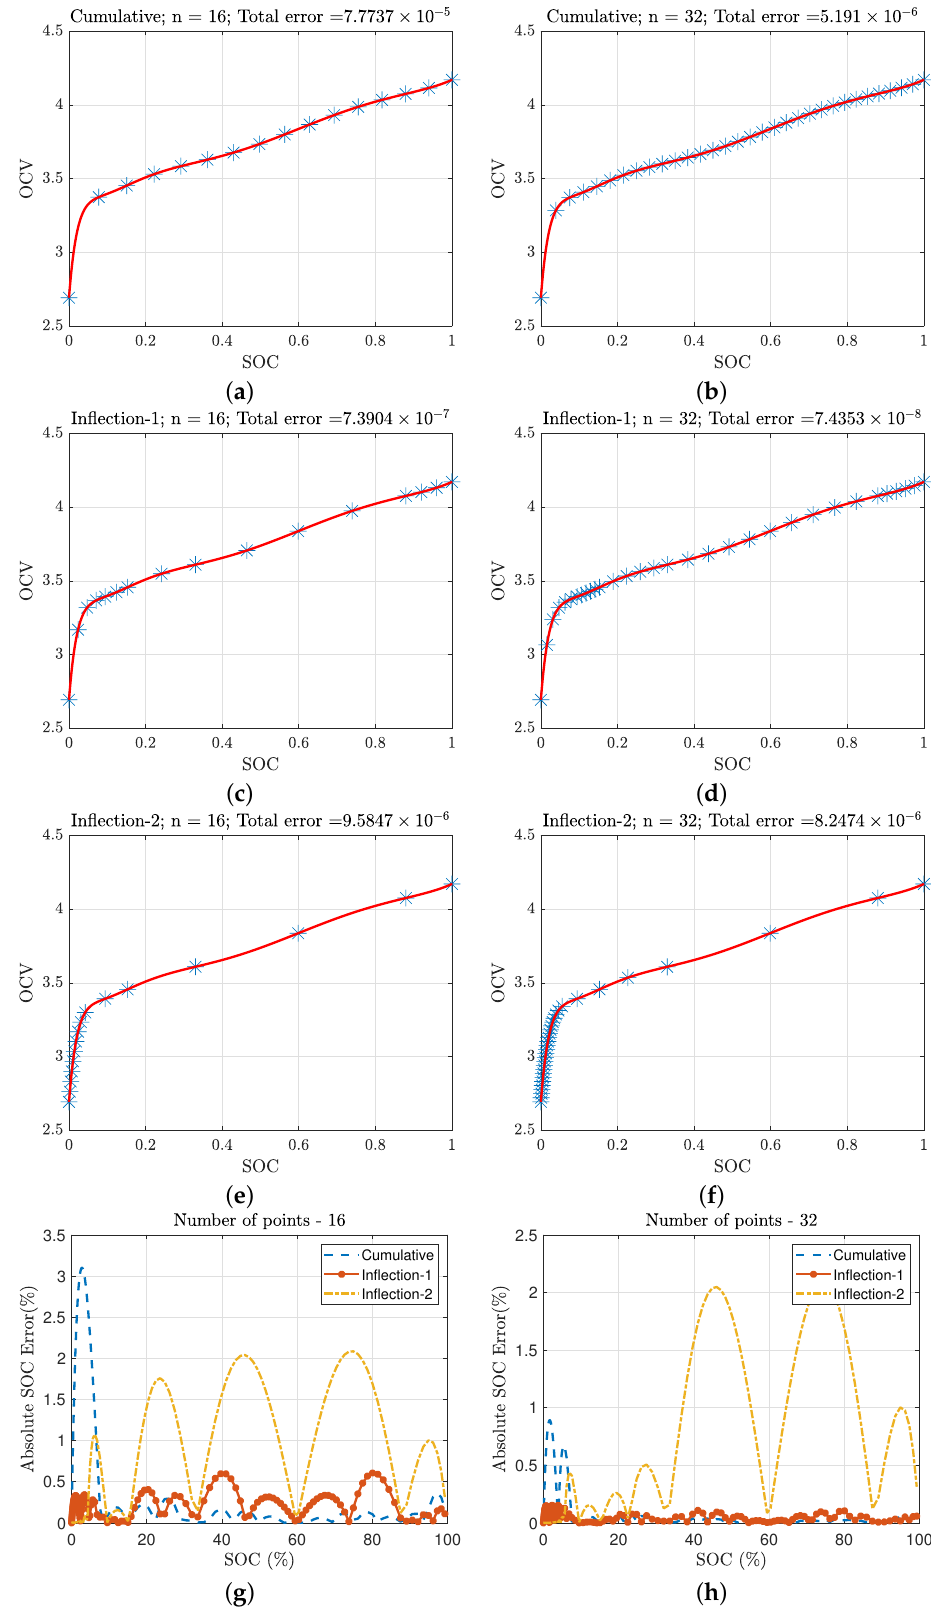
Figure 14. Tabular approximation error—( a ) cumulative-16 point, ( b ) cumulative-32 point, ( c ) inflection-1-16 point, ( d ) inflection-1-32 point, ( e ) inflection-2-16 point, ( f ) inflection-2-32 point, ( g ) SOC lookup error for 16 points, and ( h ) SOC lookup error for 32